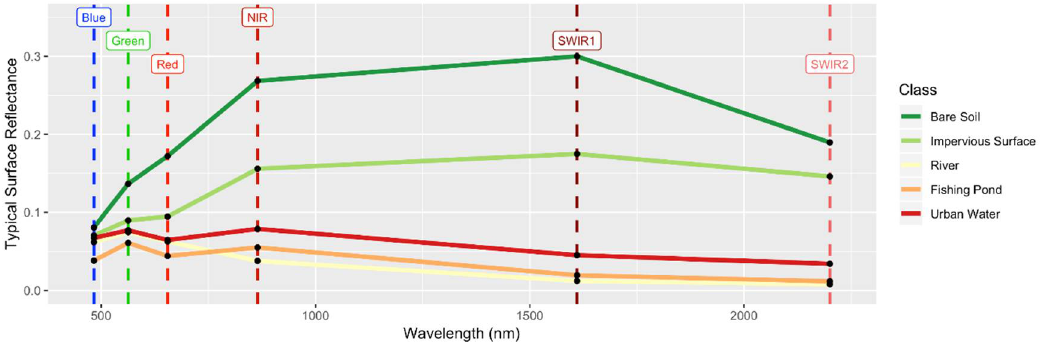
Figure 9. Typical spectral characteristics of different LCLU classes.